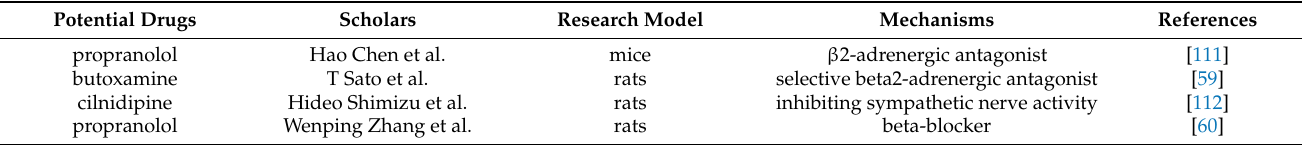
Table 3. Potential drugs inhibit osteoporosis through sympathetic